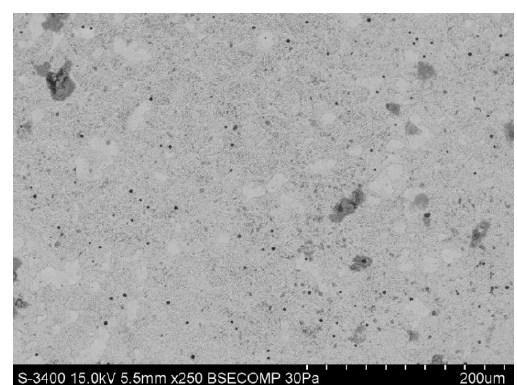
Figure 14. Metallographic image for affected region [11]